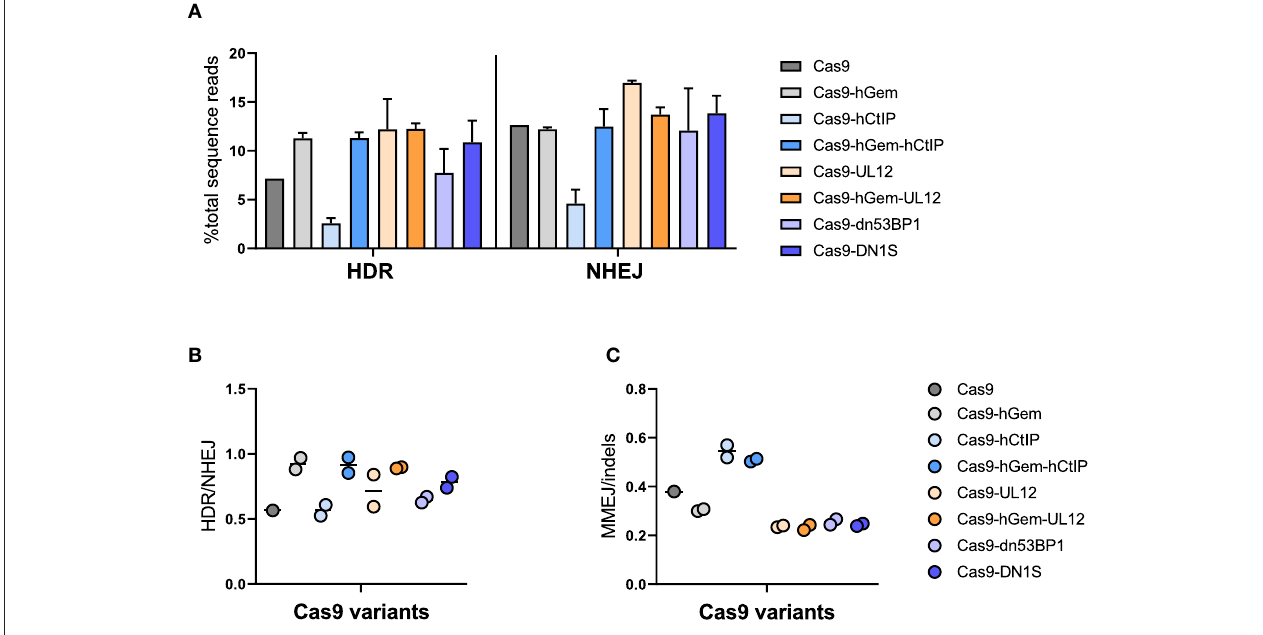
FIGURE 7 | Cas9 variant gene editing of the HBB locus with a ssODN donor. CD34 + HSPCs edited with Cas9 variants (3 pmol Cas9 mRNA + 120 pmol IVT sgRNA) and ssODN donor (3 µ M). Editing outcomes were measured by MiSeq HTS 4 days post-electroporation. Cas9 and Cas9-hGem were used as controls. (A) HDR and